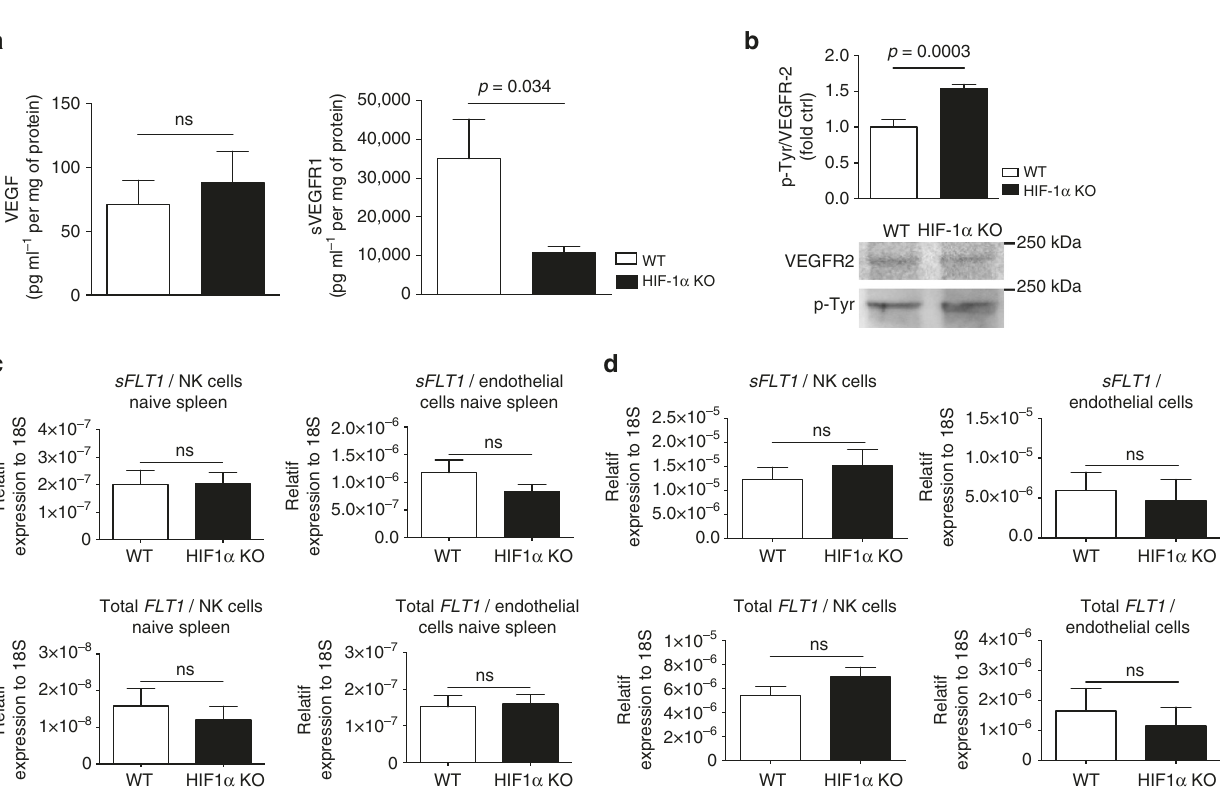
NK cell HIF-1 α de fi ciency increases VEGF bioavailability . Functional angiogenesis and the formation of mature vessels require the balanced release of angiogenic and angiostatic fac- tors 3,4,6 . Gene expression analysis for angiogenic and angiostatic factors at endpoint (Supplementary Fig. 3a) revealed, in addition to changes in fi broblast growth factor-2 and angiopoietin-2 expression, a marked decrease in the expression of the angiostatic soluble form of VEGF receptor 1 ( sVEGFR1 ) in tumours from HIF-1 α KO mice, whereas VEGF expression was similar across genotypes (Supplementary Fig. 3a). This pattern was con fi rmed on tumour protein lysates by ELISA (Fig. 3a and Supplementary Fig. 3b). sVEGFR1 binds and sequesters VEGF with high af fi nity, thus reducing VEGF bioavailability and angiogenic signalling in the tumour microenvironment 4,23 . Hence, we determined whe- ther VEGF-dependent signalling to the tumour endothelium was affected by the loss of HIF-1 α in NK cells. VEGFR2 is an endo- thelial cell-speci fi c receptor tyrosine kinase that is critical for VEGF signalling 23 . By immunoprecipitating VEGFR2 from tumour lysates and probing with anti-phosphotyrosine followed by anti-VEGFR2 antibody via Western blot, we quanti fi ed total and activated VEGFR2 from whole tumour lysates 6 . As shown in Fig. 3b and Supplementary Fig. 3c, loss of HIF-1 α in NK cells signi fi cantly increased the ratio of phosphorylated VEGFR2 relative to total VEGFR2, when compared to WT conditions. The